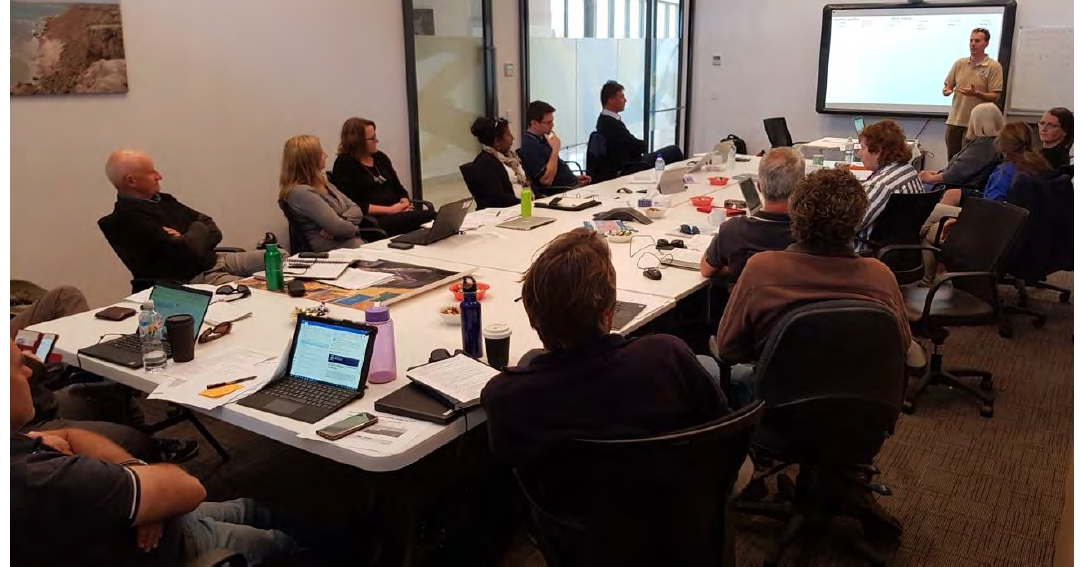
Figure 1.1 Undertaking the first phase of the CVI process during the September 2018 workshop in